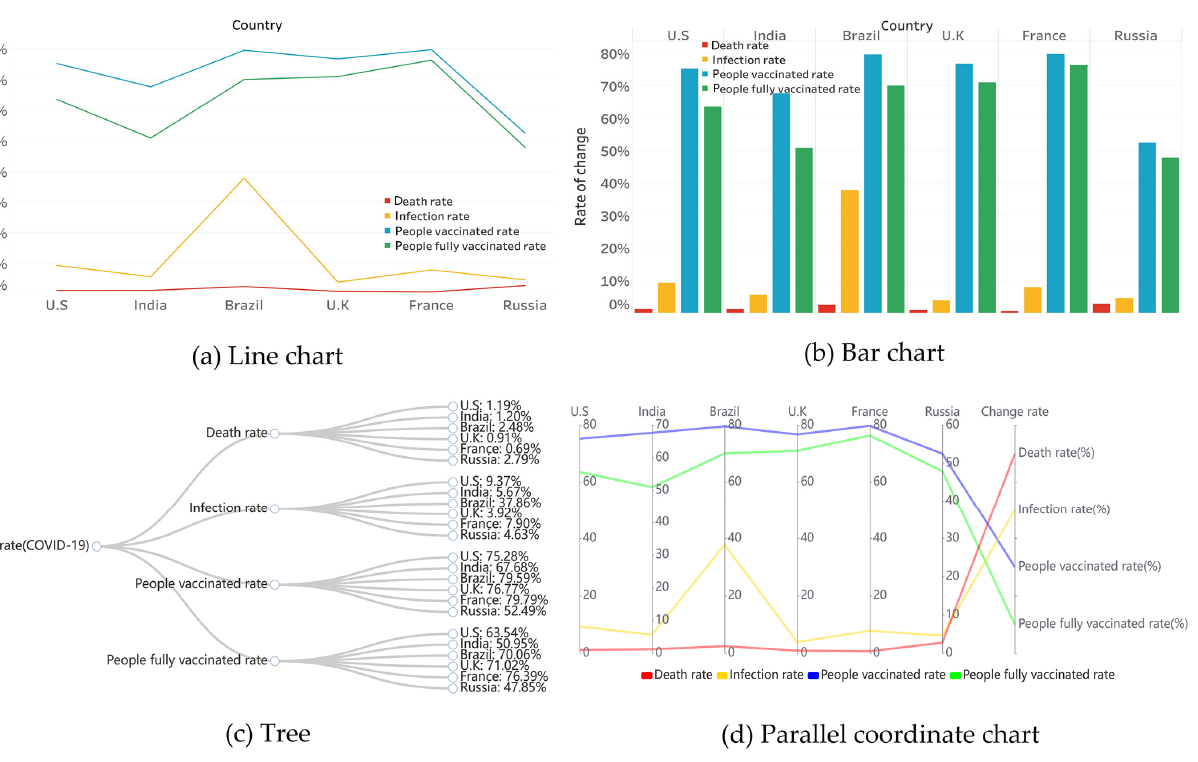
Figure 3. Epidemic statistics in six countries (January 2020–January 2022)-traditional chart. ( a ) line chart. ( b ) bar chart. ( c ) tree. ( d ) parallel coordinate chart.